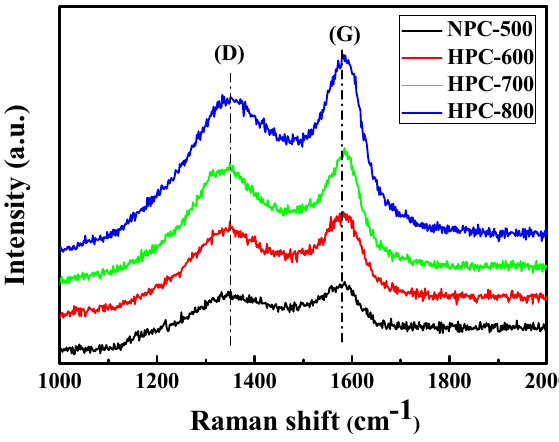
Figure 3. Raman spectra of the NPC-500, HPC-600, HPC-700, and HPC-800.